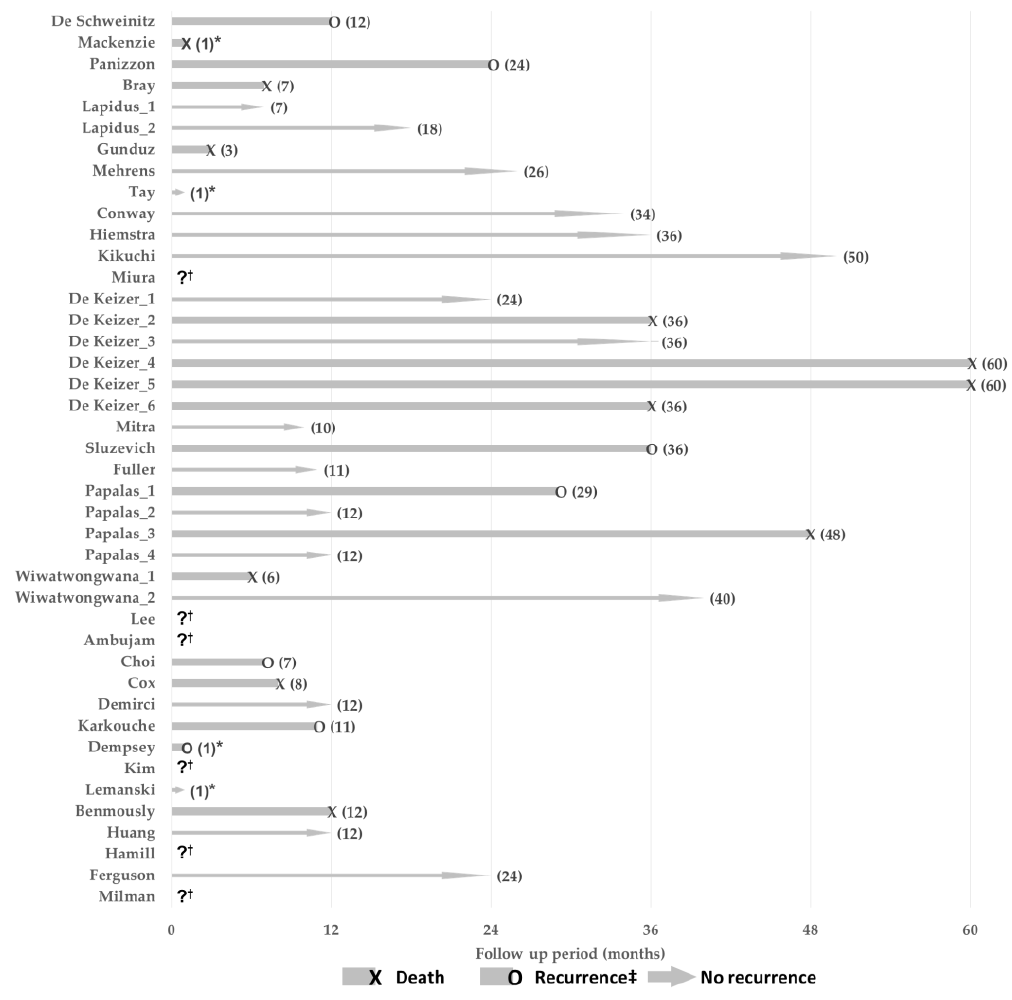
Figure 2. Follow-up period and treatment outcome of each case [5 – 36]. * Cases which clear follow-up period could not be confirmed in the paper were indicated as 1 month, † Cases which the treatment outcome could not be confirmed in the paper were left blank with a question mark, ‡ Recurrence with disease worsening.